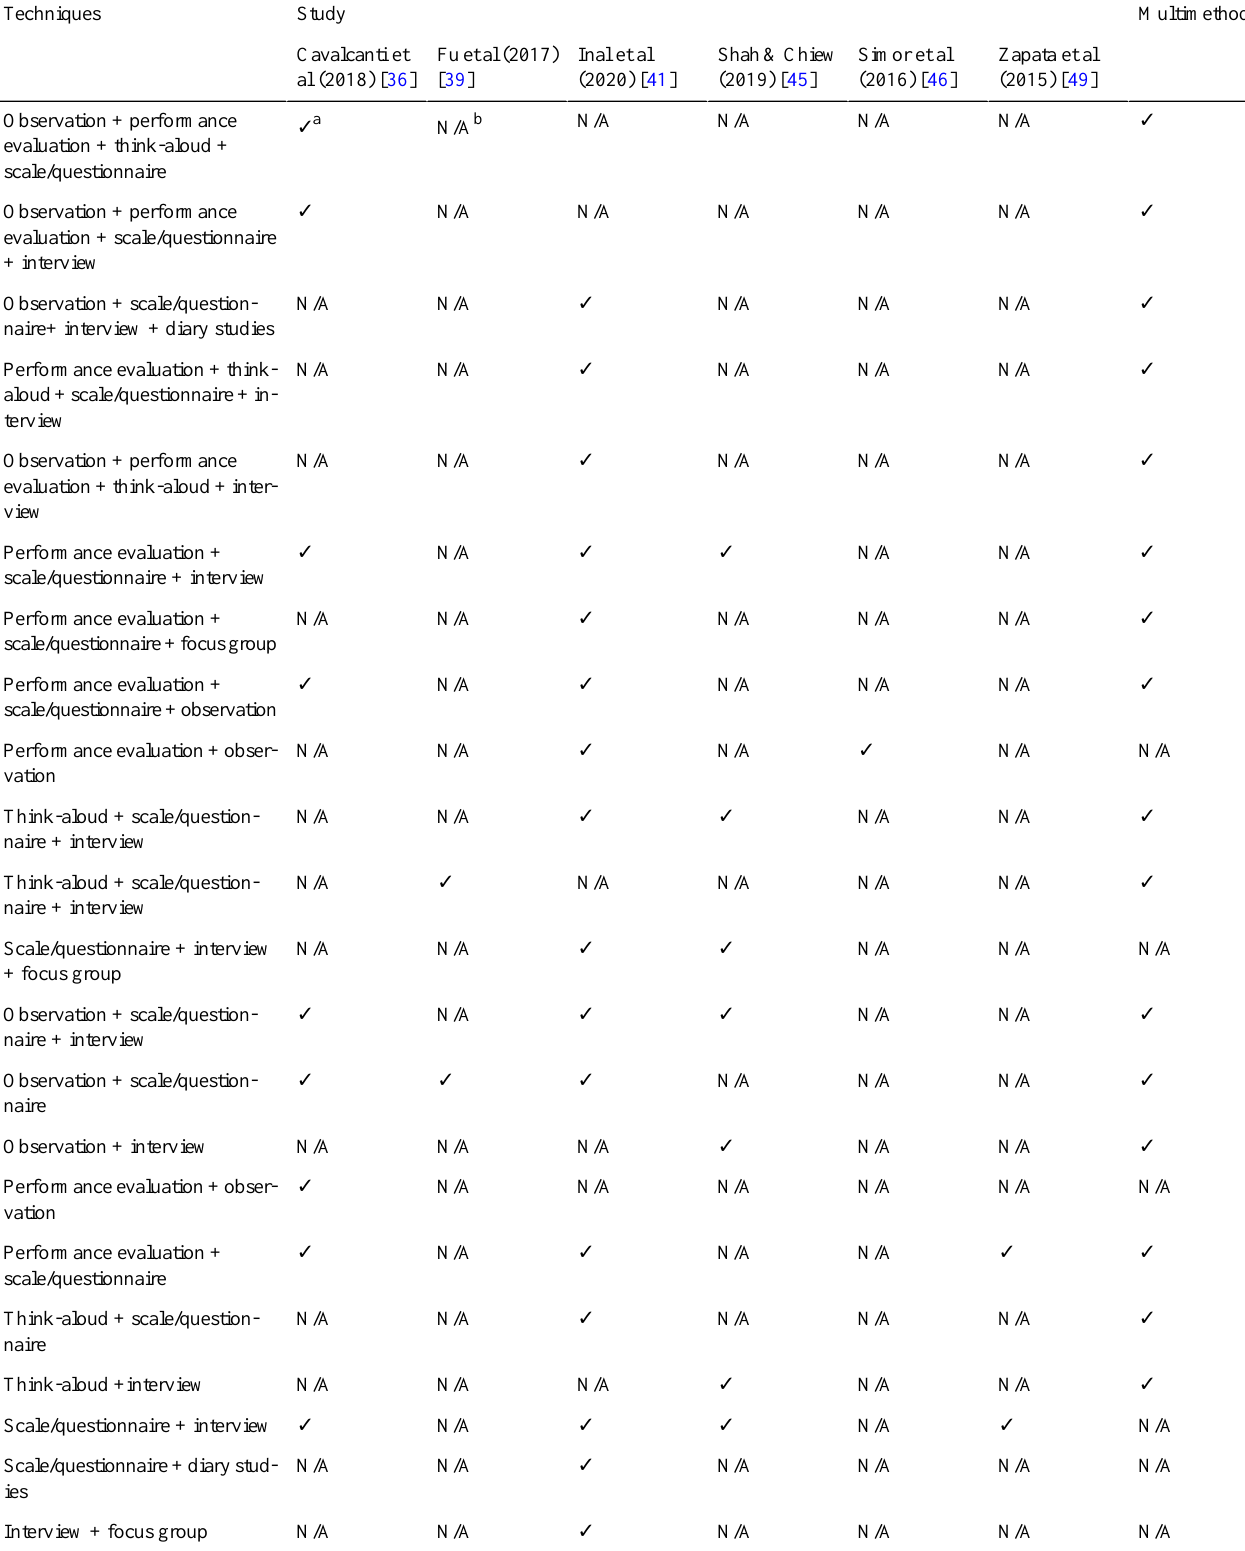
Table 4. Detailed description of the combination of techniques used for usability